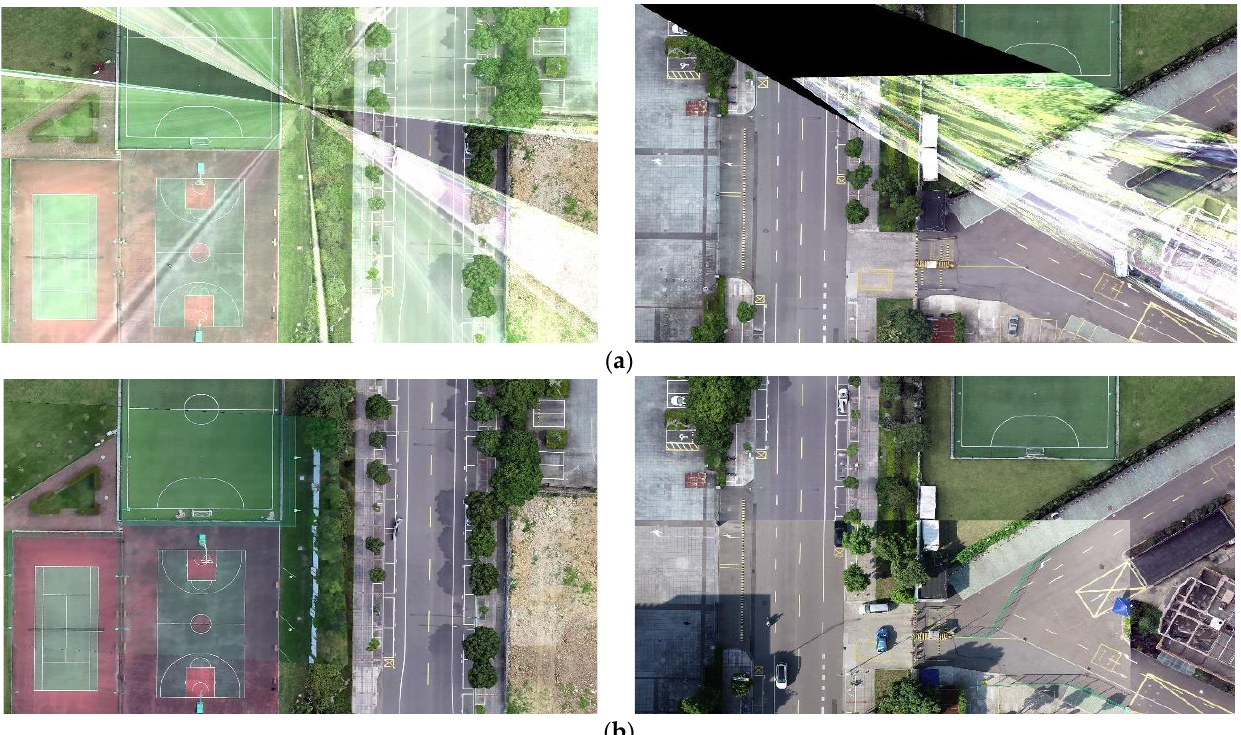
Figure 11. Registration effect: ( a ) Orb algorithm; ( b ) our proposed method.